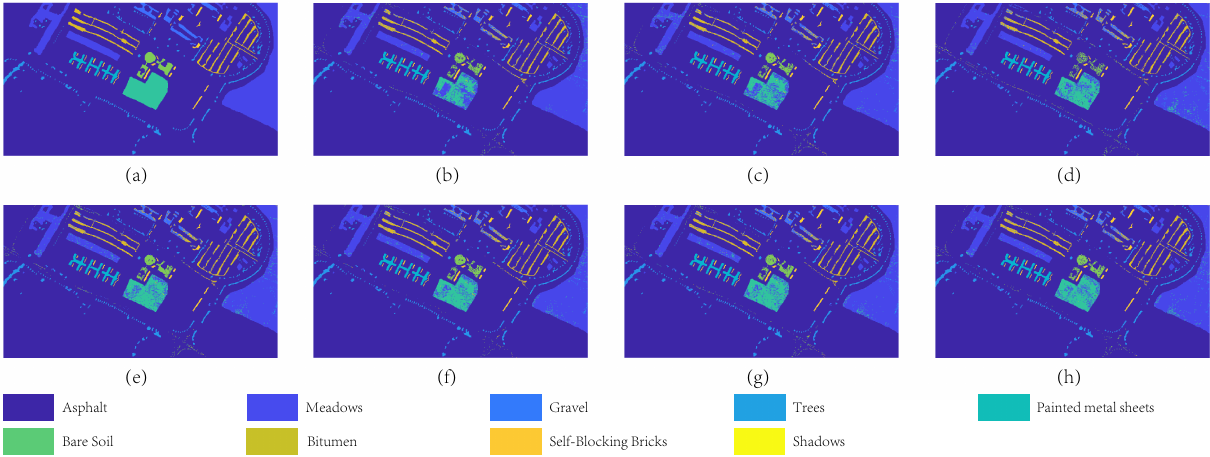
Figure 3. The visualization of classification on the Pavia University dataset. ( a ) Ground truth; ( b ) TRC-OC-FDPC; ( c ) UBS; ( d ) PCAS; ( e ) ONR; ( f ) NC-OC-MVPCA; ( g ) NC-OC-IE; ( h ) BAMGC.